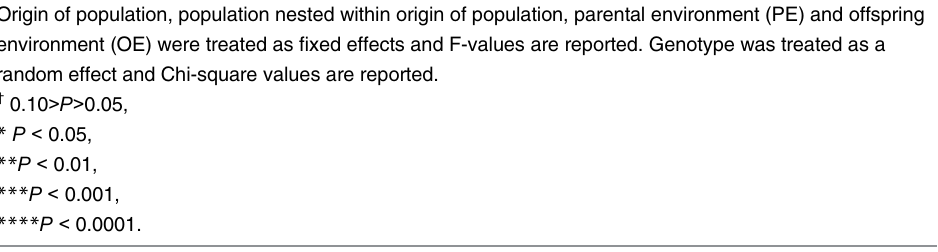
Origin of population, population nested within origin of population, parental environment (PE) and offspring environment (OE) were treated as fi xed effects and F-values are reported. Genotype was treated as a random effect and Chi-square values are reported.